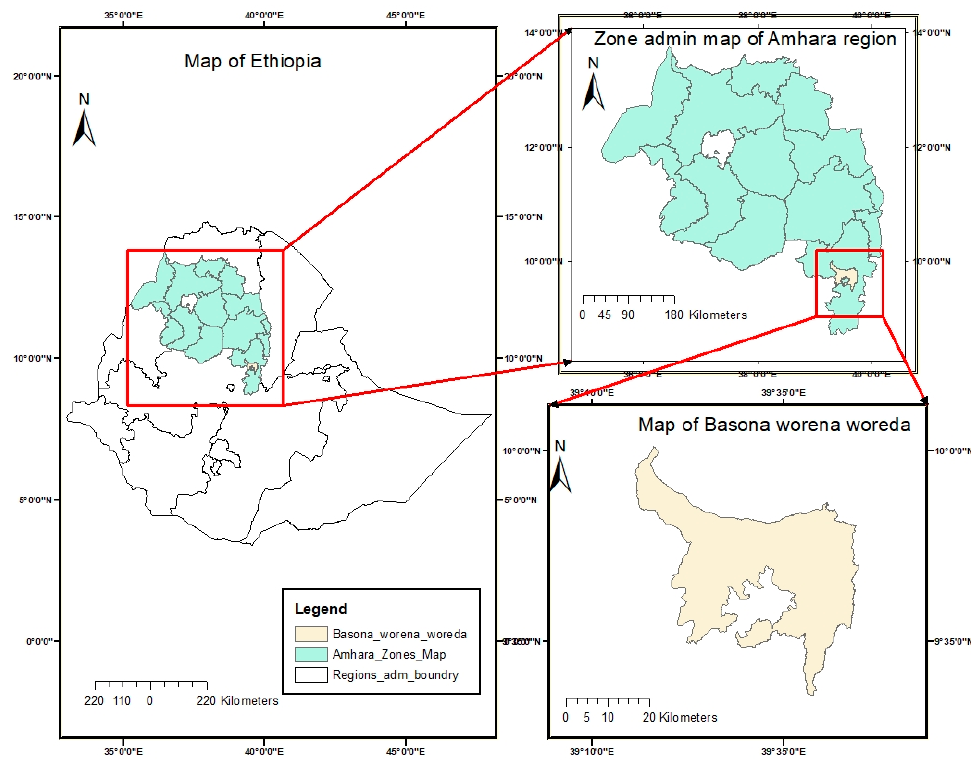
Figure 2. Study Site Map. Map organized by the authors based on the 2018 updated shape file/map of Ethiopia by Central Statistical Agency under the auspices of the Ministry of Finance.